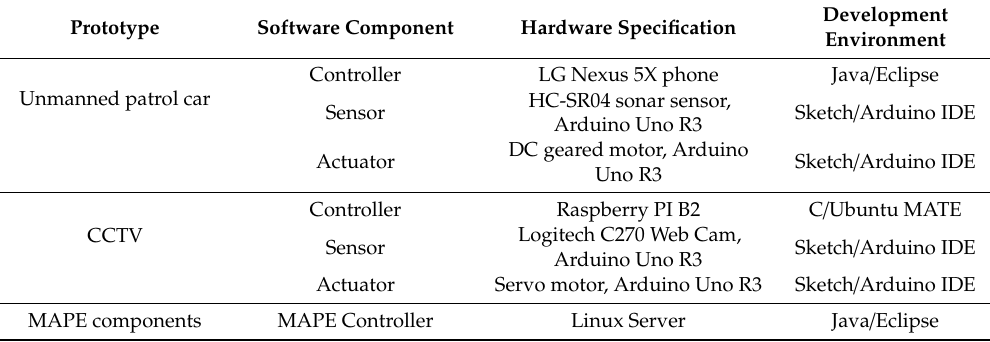
Table 3. Hardware components and development environments for the